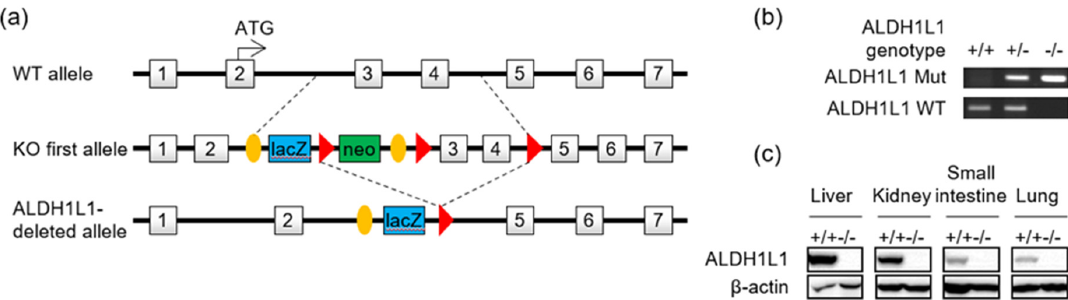
Figure 3. Generation of Aldh1l1 -knockout mice. ( a ) Strategy for generating Aldh1l1 knockout mice. ( b ) Aldh1l1 gene disruption was confirmed by PCR genotyping. Tail genomic DNA was amplified, with specific primers for wild-type (311 bp) and mutant (307 bp) Aldh1l1 alleles. +/+ , wild-type; +/ − , heterozygous; − / − , homozygous (knockout). ( c ) Immunoblotting analysis showing the absence of ALDH1L1 in protein extracts of tissues from an Aldh1l1 − / − mouse. Detailed information about western blot can be found at Figure S2.